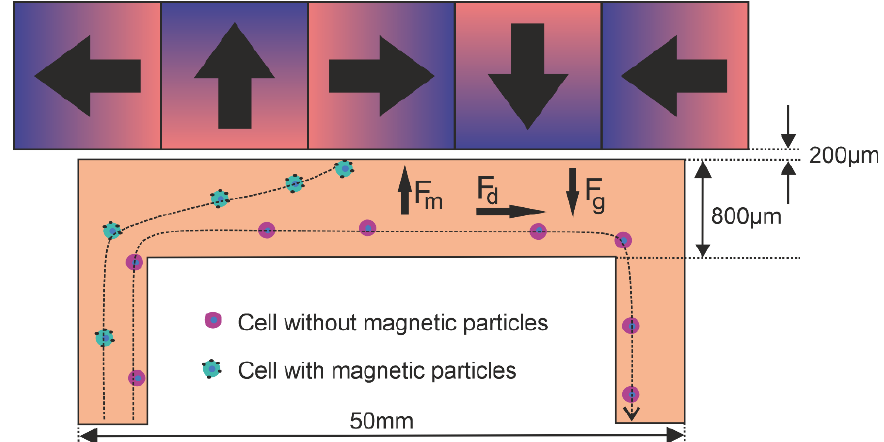
Figure 1. Schematic representation of the magnetophoretic flow separation setup comprised of a flow channel with a Halbach array showing the magnetic ( F m ), drag ( F d ) and gravitational force ( F g ).